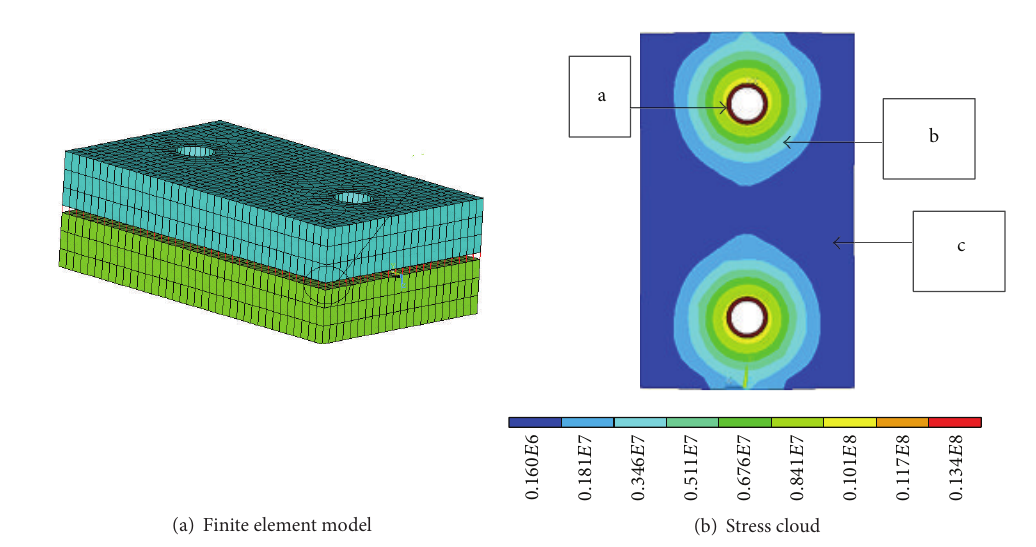
Figure 13: FEM model and stress